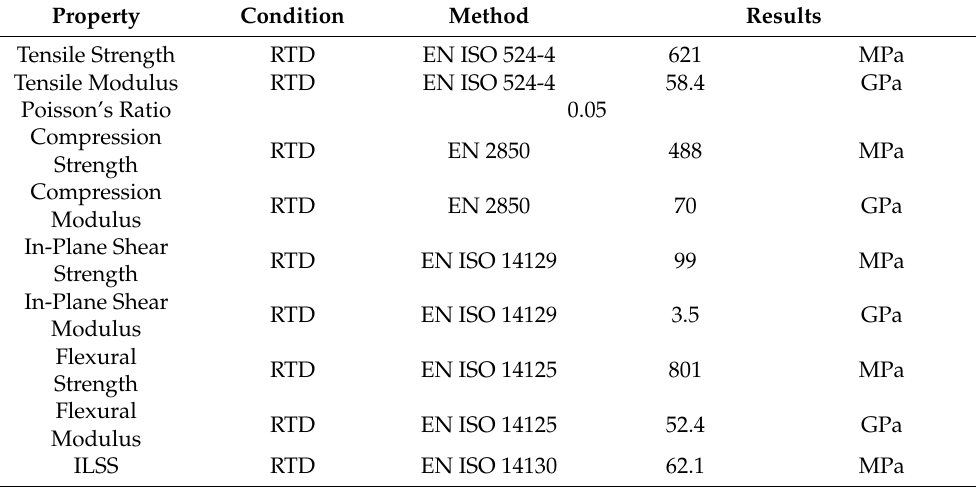
Table 1. Mechanical Properties of Carbon Fiber.